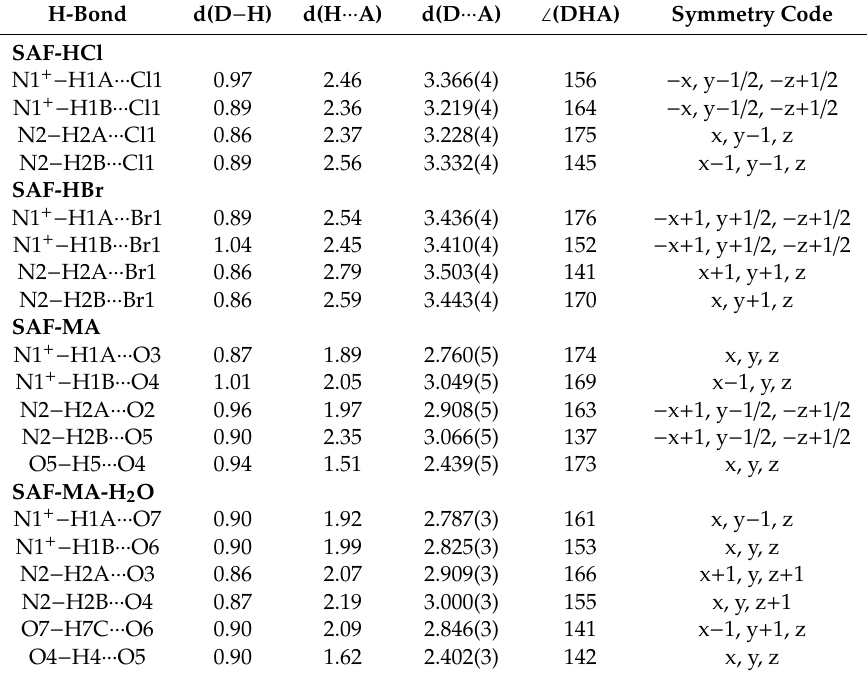
Table 2. Hydrogen bond distances (Å) and angles ( ◦ ) of safinamide and its salts.